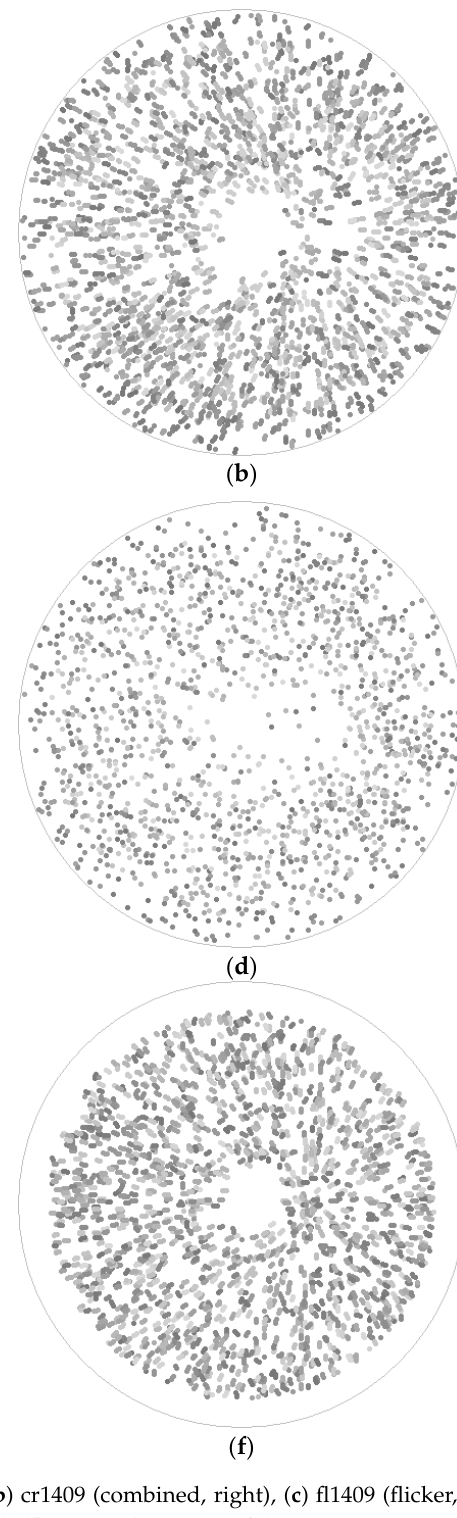
12 of 19 Figure 8. Working session with the main unit of the SimulationCenter application.